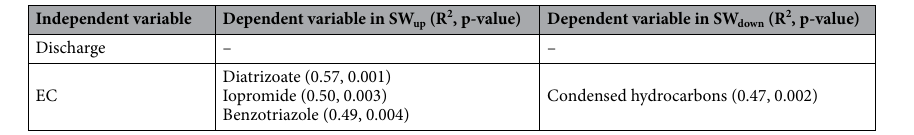
Table 1. TrOCs and DOM compound classes for which linear regression with discharge or EC had an R 2 > 0.33 and p-value < 0.01, classified by surface water sampling site.